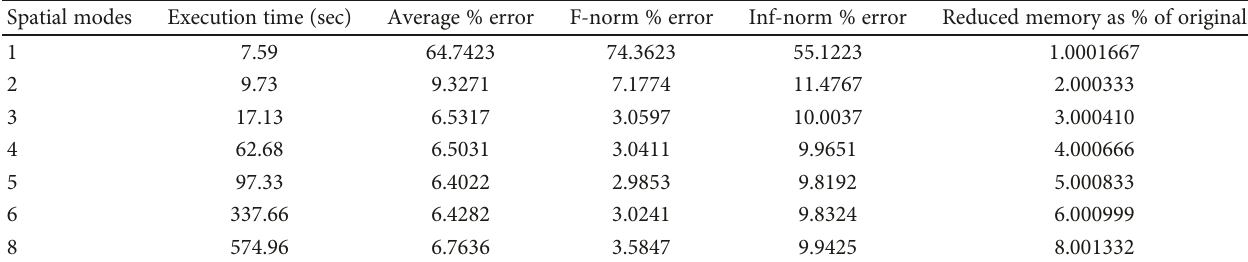
Figure 5: The simulated compressor rotor [13]. Table 7: 3D model of density over 100 time steps.